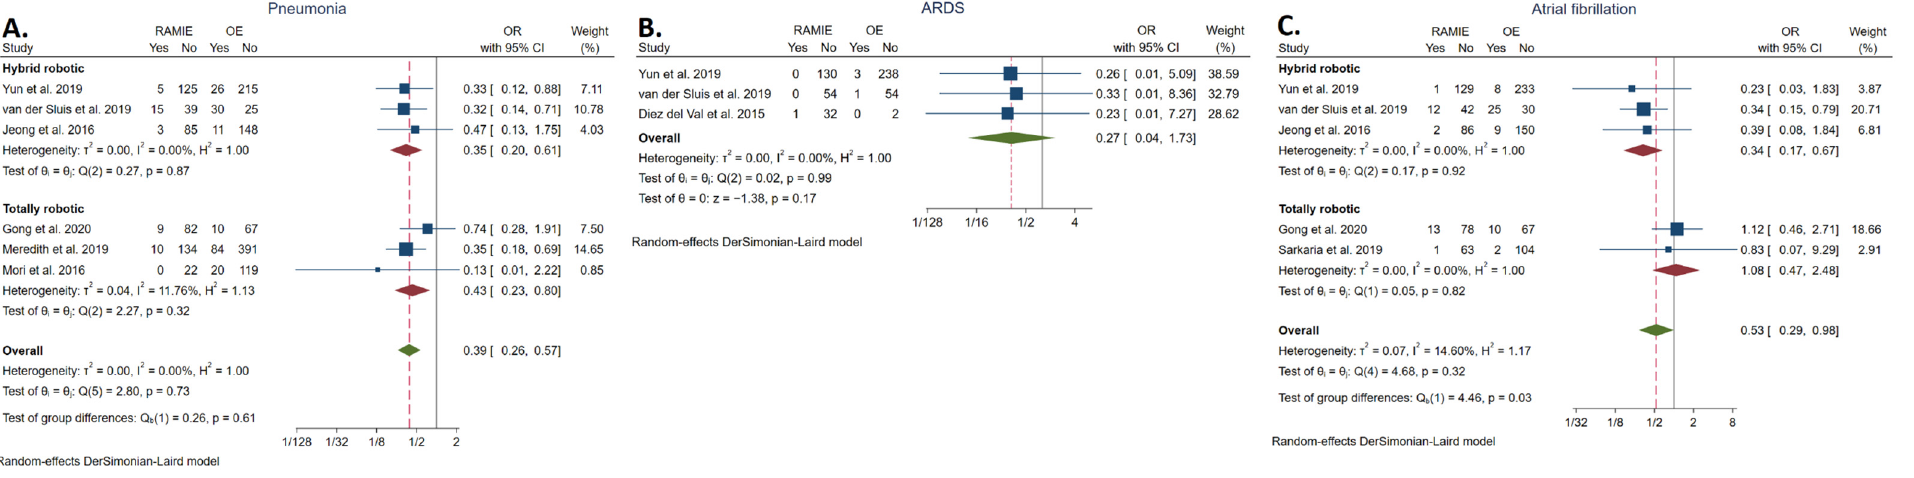
Figure 5. Forest plots of pneumonia rate ( A ), acute respiratory distress syndrome rate ( B ), and atrial fibrillation rate ( C ) [21,23,34–37,39,41].